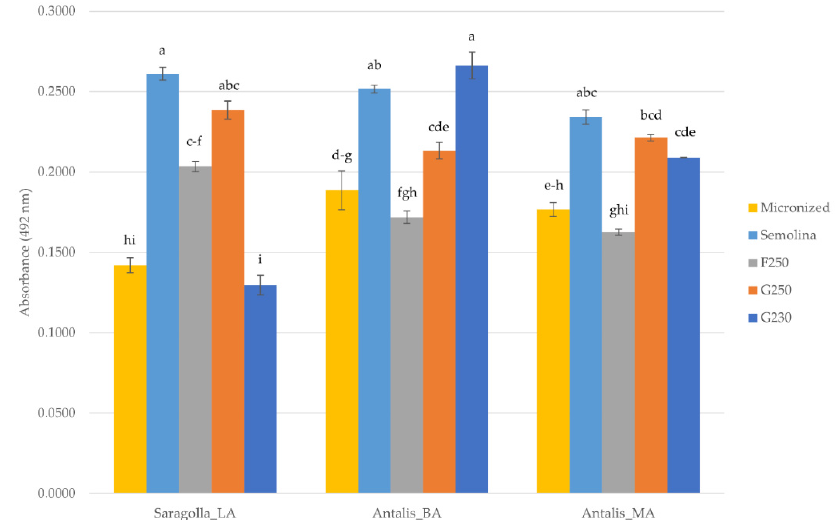
Figure 6. Indirect ELISA performed with anti-ATI polyclonal antibodies dilution 1:200 of mi- cronized samples, semolina and air-classified fractions (F250, G250, G230) obtained from the durum grain samples used in this study. Different letters indicate significant differences ( p < 0.05).